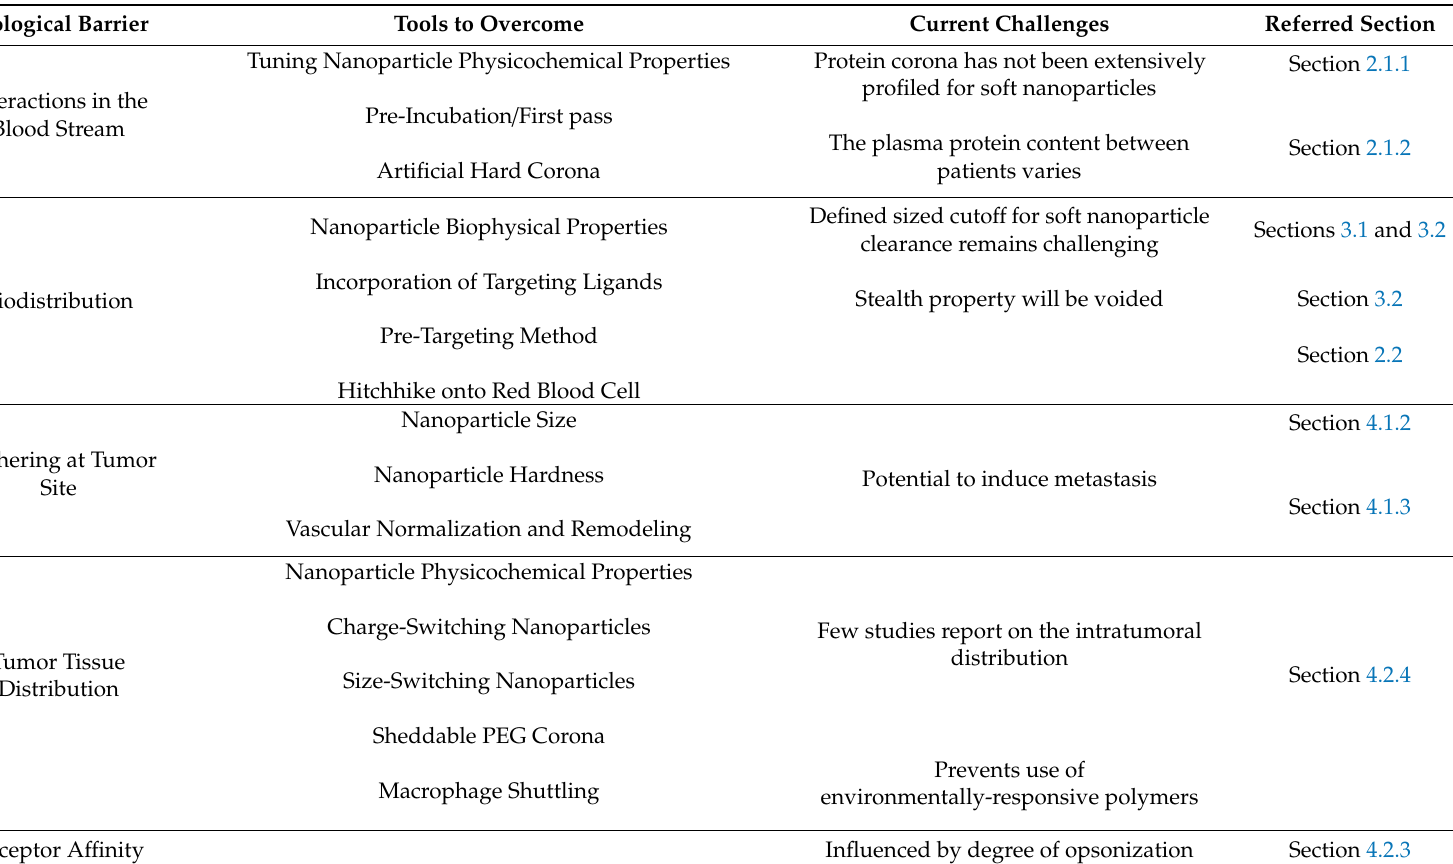
Table 1. Tools to overcome the biological barriers of